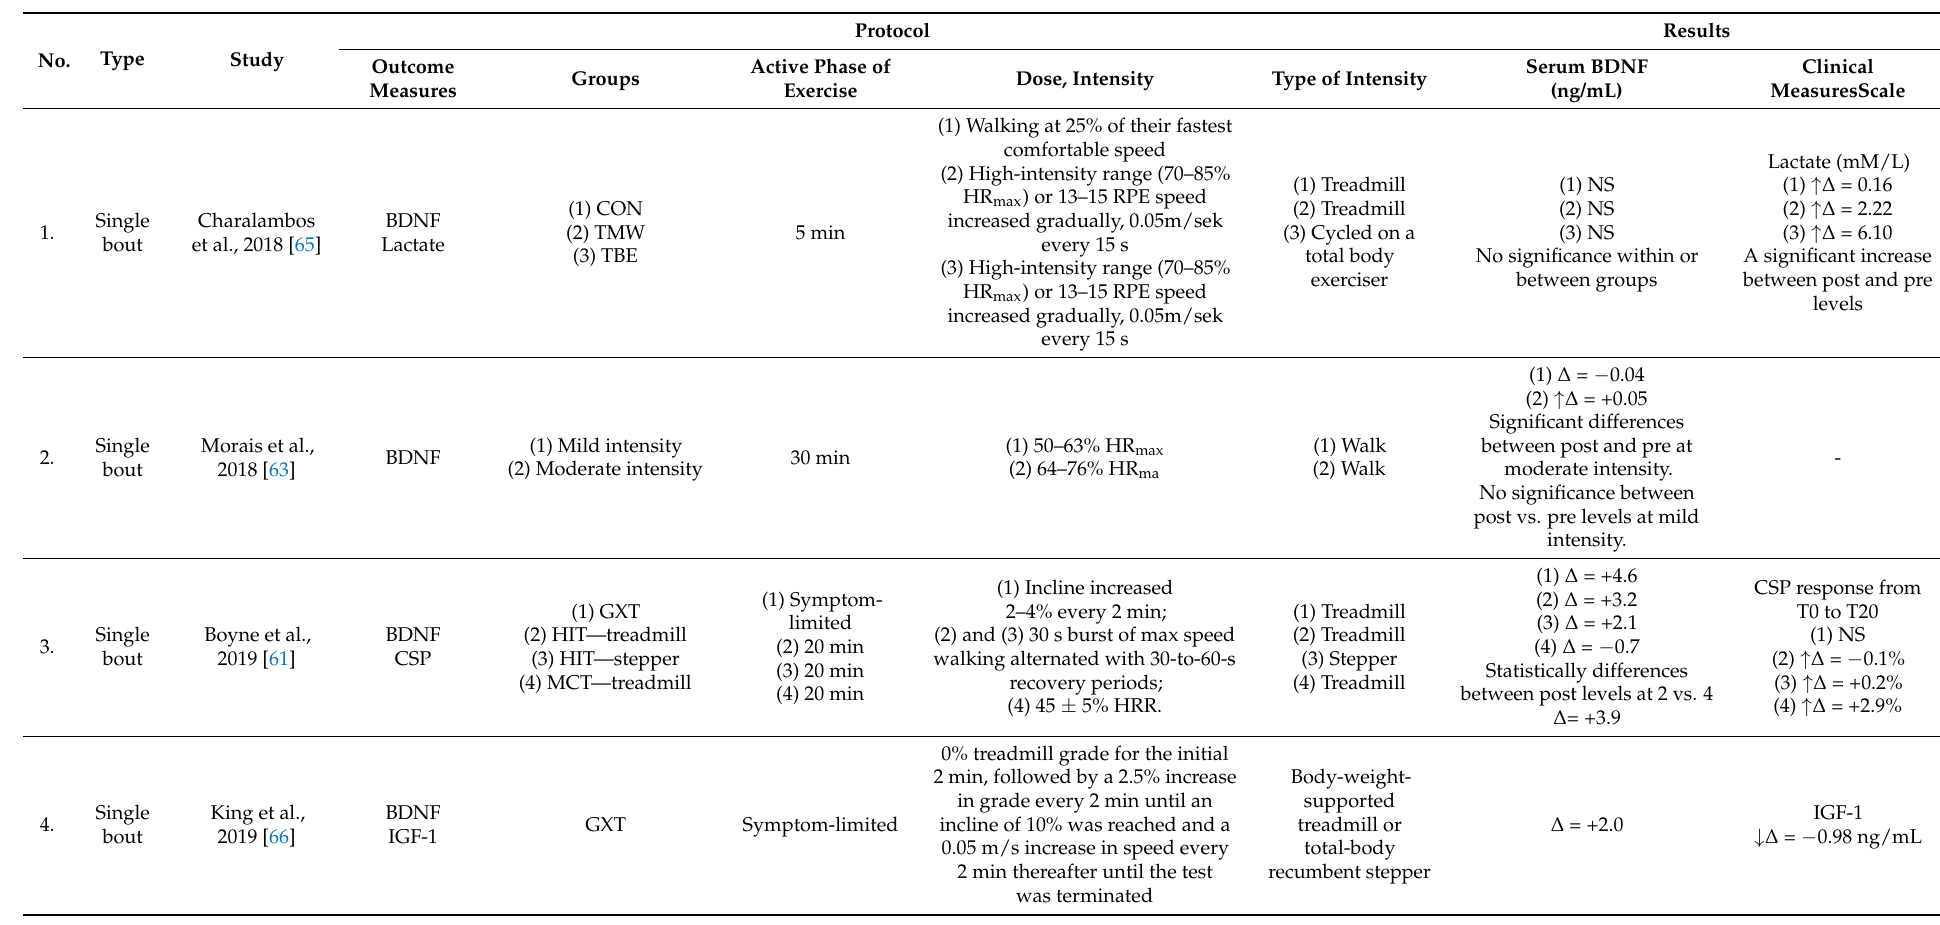
Table 4. Methodological characteristics and main results of studies assessing the effects of endurance exercise on the BDNF concentration